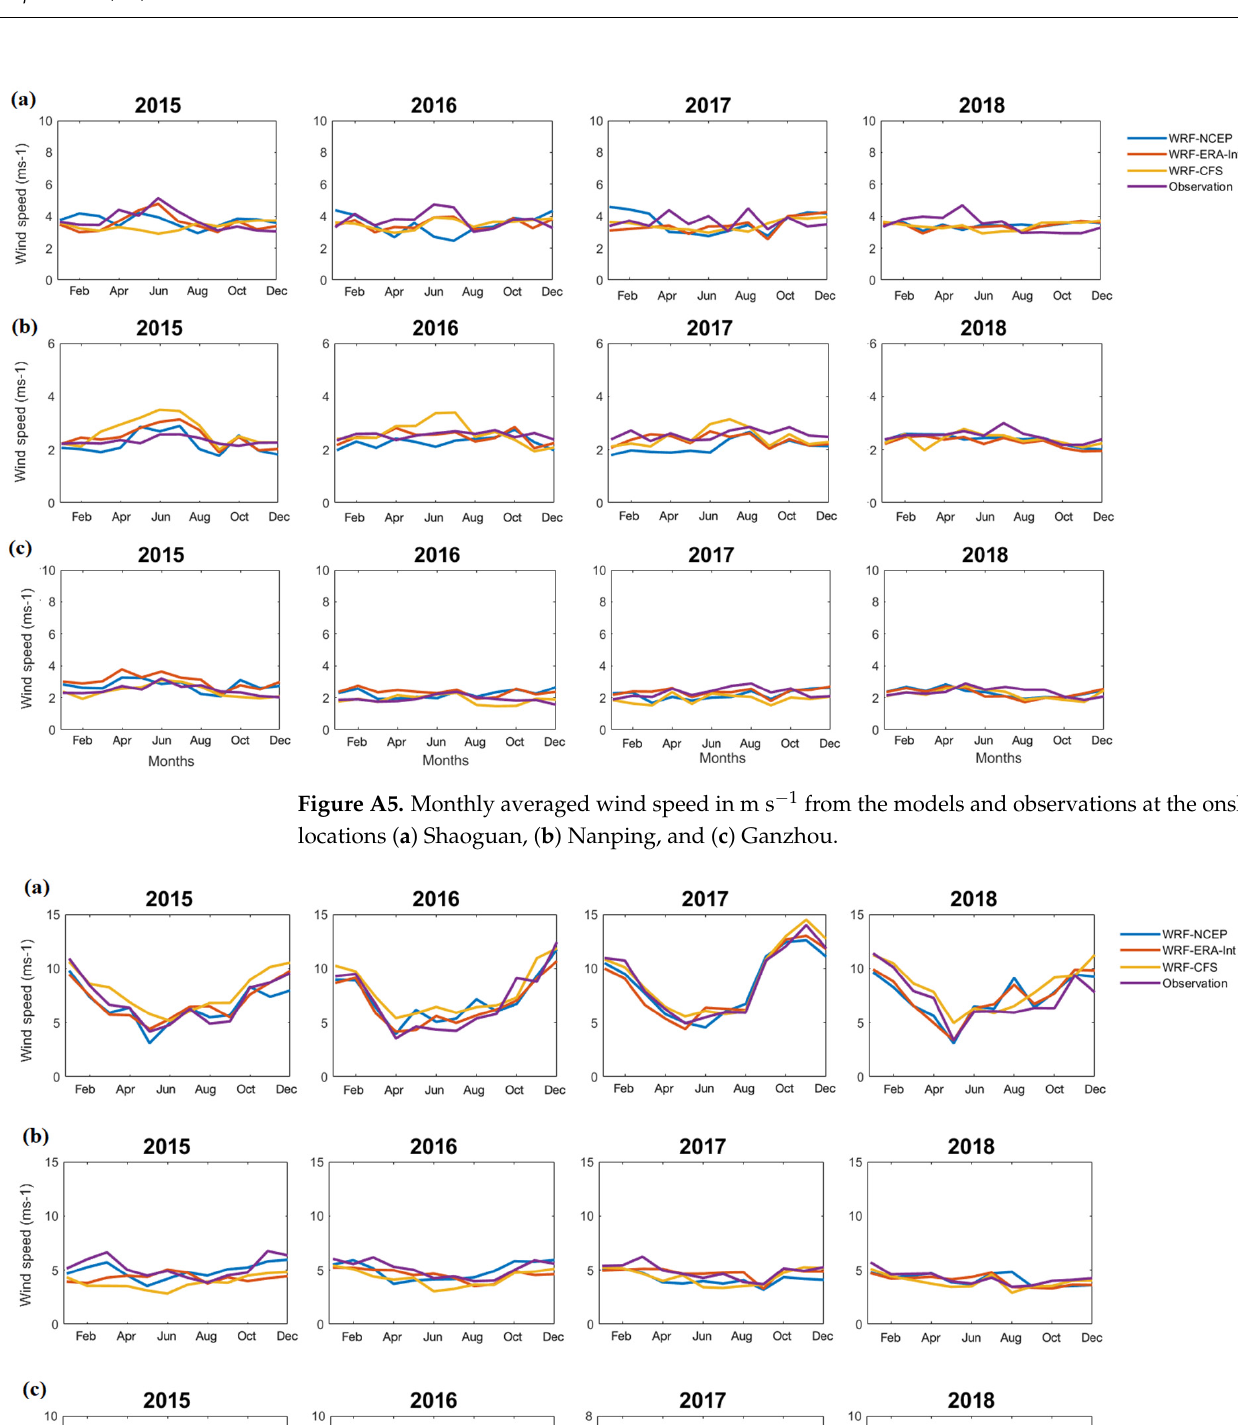
Figure A4. Taylor diagram for wind speed in m s − 1 from the models and observations at the locations ( 1 ) Shaoguan, ( 2 ) Nanping, ( 3 ) Ganzhou, ( 4 ) Offshore Quanzhou, ( 5 ) Offshore Shanwei, ( 6 ) Offshore Nansan, ( 7 ) Dongsha, ( 8 ) Zhanjiang and ( 9 ) Hong Kong.